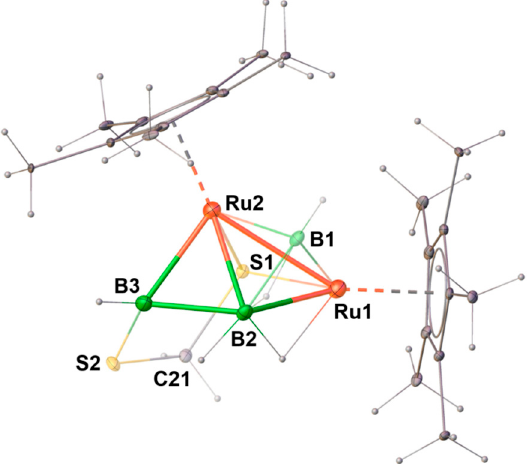
Figure 2. Molecular structure and labelling diagram of 5 : B1–B2 1.679(11), B1–Ru2 2.098(7), B1–Ru1